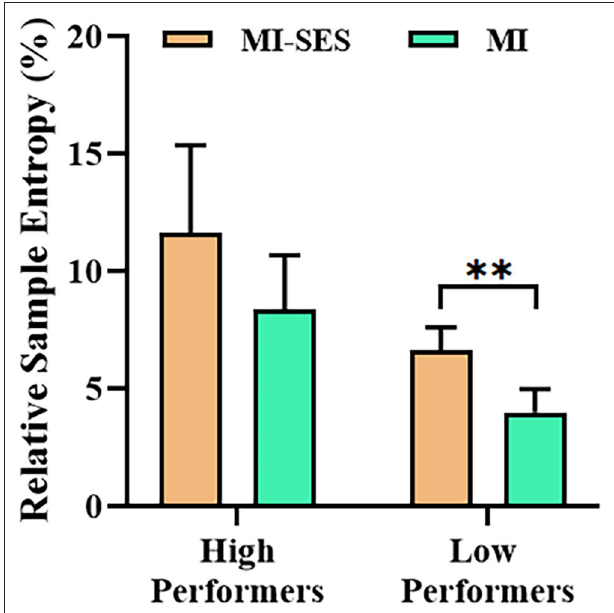
FIGURE 7 | Averaged relative sample entropy values of C3 channel in MI-SES and MI conditions. Error bars represent standard error of mean. “**” indicates p <